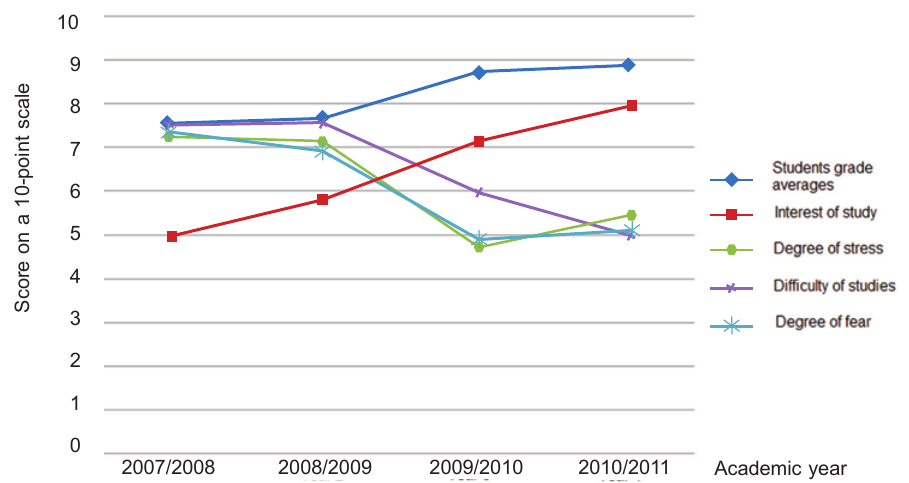
Figure 2. The dependence of student grade averages on the stress, difficulty of studies and